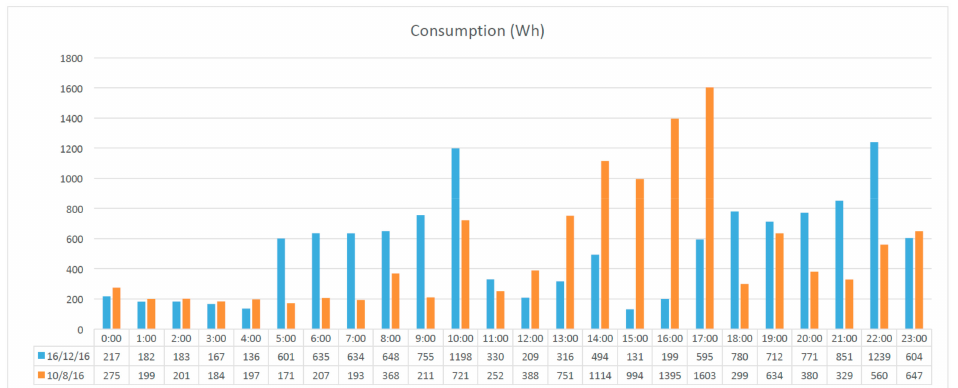
Figure 4. Examples of the dwelling energy consumption in a winter and summer day before